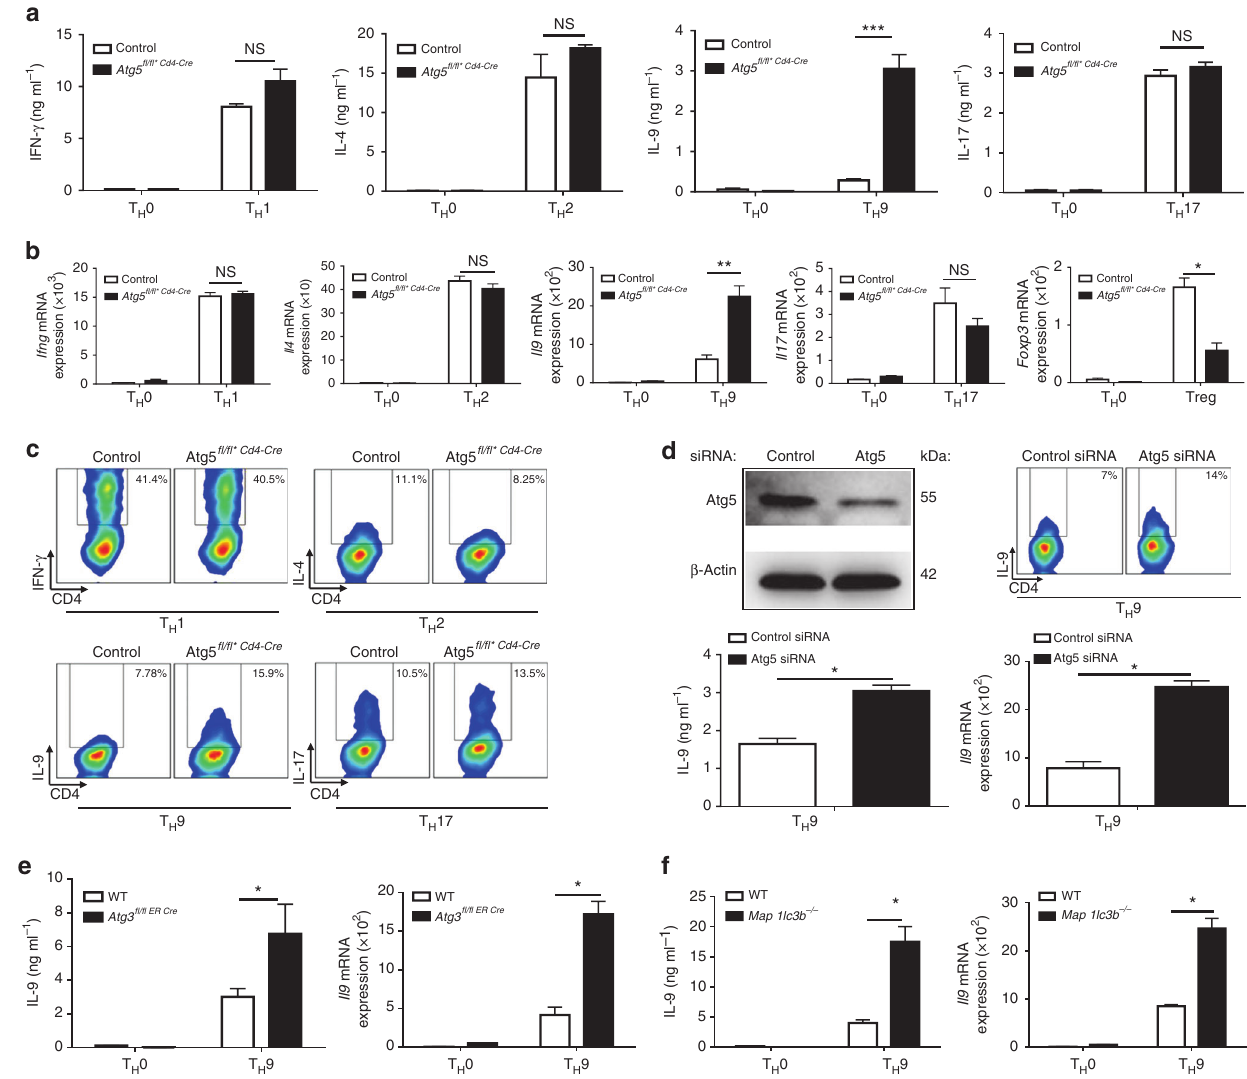
Fig. 1 The autophagy-related proteins Atg5, Atg3 and LC3-II negatively regulate T H 9 cell differentiation in vitro. Cell-sorted naive CD4 + CD62L hi CD44 lo T cells were isolated from control and conditional Atg5-de fi cient (Atg5 fl / fl *CD4-Cre ) mice and differentiated into T H 0, T H 1, T H 2, T H 9 and T H 17 cells in the presence of plate-bound anti-CD3 and anti-CD28 antibodies for 72 h. a ELISA of IFN- γ , IL-4, IL-9 and IL-17 in supernatants of T H 0, T H 1, T H 2, T H 9 and T H 17 cells differentiated for 3 days from Atg5 fl / + *CD4-Cre and Atg5 fl / fl *CD4-Cre naive CD4 + T cells. b Quantitative RT-PCR analysis of Ifng , Il4 , Il9 , Il17 and Foxp3 mRNA in T H 0, T H 1, T H 2, T H 9, T H 17 and Treg cells differentiated for 48 h from Atg5 fl / + *CD4-Cre and Atg5-Atg5 fl / fl *CD4-Cre naive CD4 + T cells; results were normalized to the expression of Actb (encoding β -actin) and are presented relative to control T H 0 cells. Experiment performed three times. c Flow cytometry analysis of IFN- γ , IL-4, IL-9, and IL-17 expression from T H 1, T H 2, T H 9 and T H 17 cells differentiated for 3 days from Atg5 fl / + *CD4-Cre